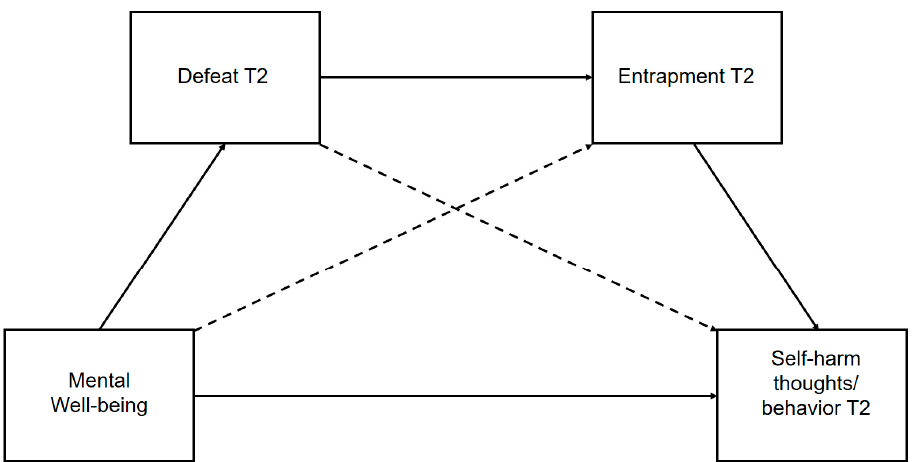
Figure2. Predictedserialmultiplemediationpathway(non-dashedlines)forassociationbetweenmental well-beingandsubsequentself-harmthoughts, viadefeatandentrapment. Predictedmultiplemediation pathway highlighted in non-dashed lines. “T2” indicates data collected at the second Figure 2. Predicted serial multiple mediation pathway (non ‐ dashed lines) for association between mental well ‐ being and subsequent self ‐ harm thoughts, via defeat and entrapment. Predicted multiple mediation pathway highlighted in non ‐ dashed lines. “T2” indicates data collected at the second time ‐ point.